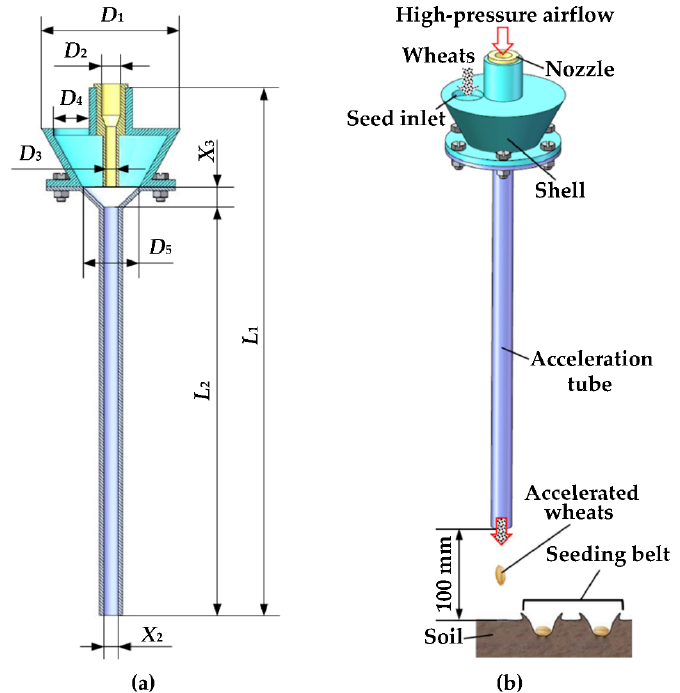
Figure 1. ( a ) Structure of the PWSD. ( b ) Pneumatic shooting principle.